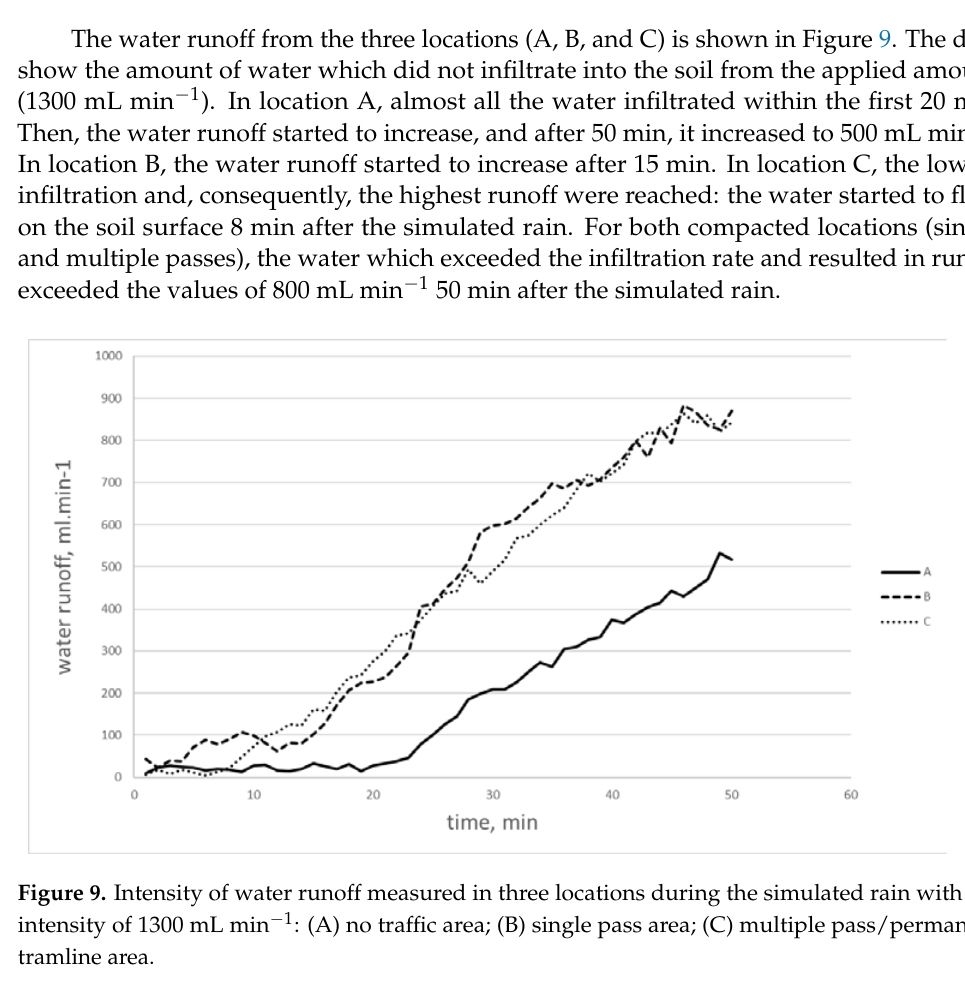
Figure 10. Weight of soil sediments sampled during the simulated rain in the three locations: (A) no traffic; (B) single pass; (C) multiple passes/permanent tramlines. 3.3. Determination of Soil Physical Parameters In order to show the effect of using the permanent tramlines and avoiding soil com- paction in the rest of the field, soil cone penetrometer resistance was measured in the three locations (Figure 11).